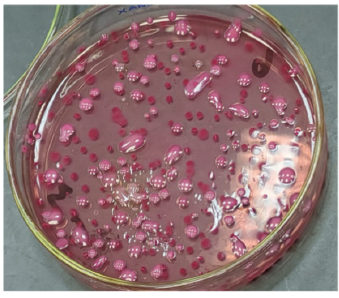
Figure 7. Quantification of STEC O111 on TBX media.